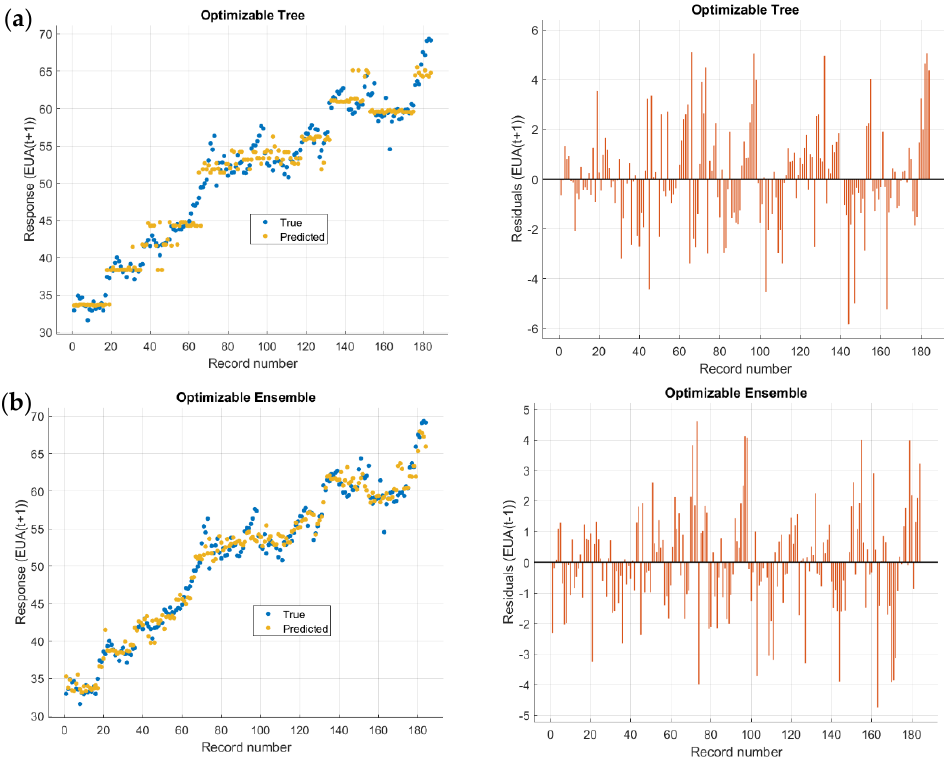
Figure 9. Comparison of results of day-ahead forecast of carbon price using ( a ) optimizable medium tree and ( b ) optimizable ensemble tree (for training data). Table 3. Prediction errors of SVM, NNR, GPR